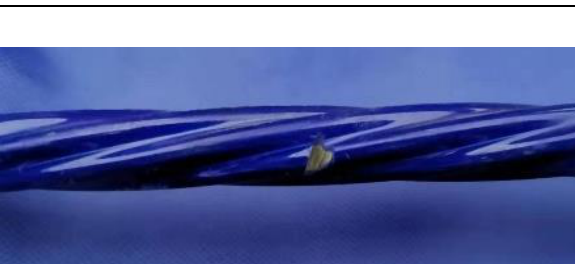
Figure 2. Prefabricate a notch on the steel strand.